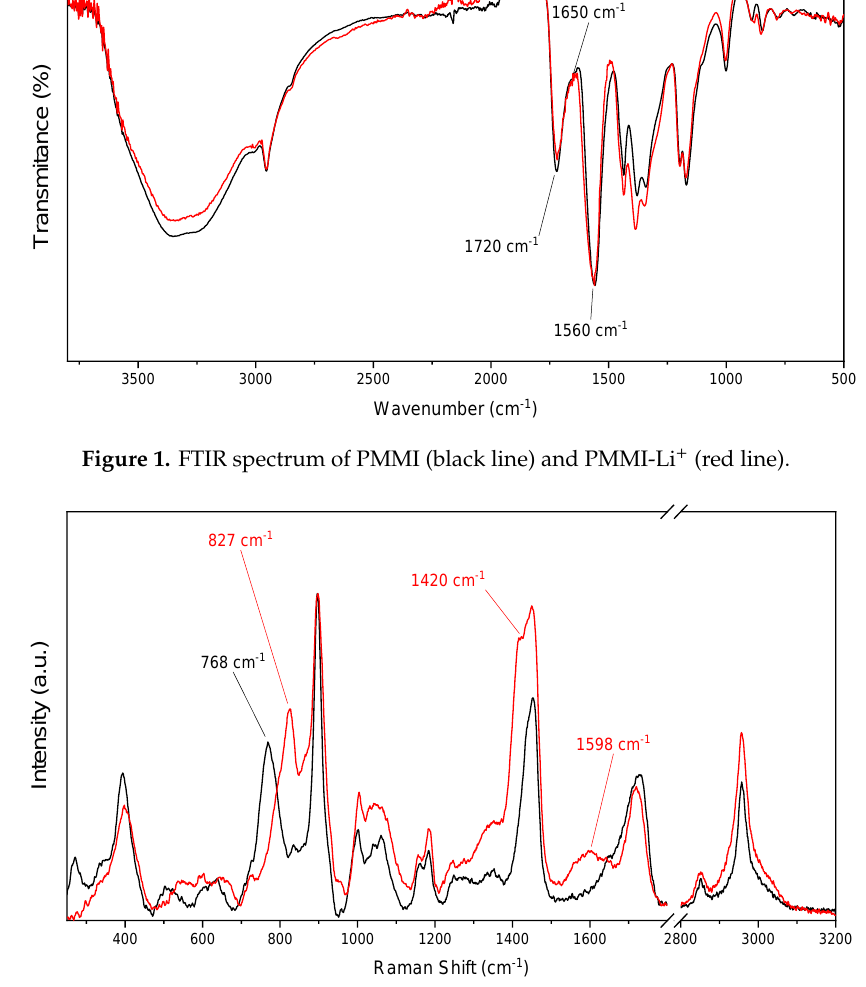
Figure 2. Raman spectrum of PMMI (black line) and PMMI-Li + ions (red line).